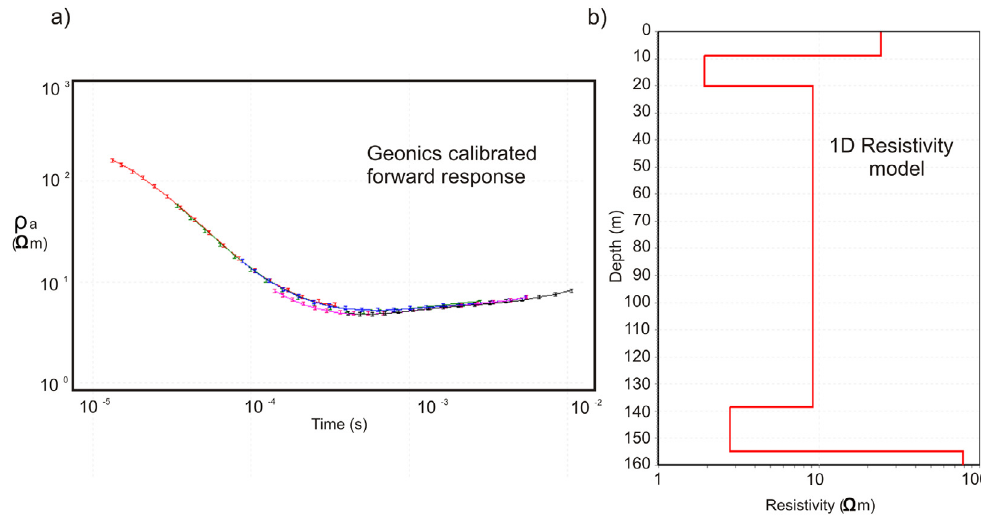
Figure 10. (a) Forward response of the calibrated 100 × 100 m loop data plotted as late-time apparent resistivity. (b) Recovered 5 layers 1-D resistivity model after data